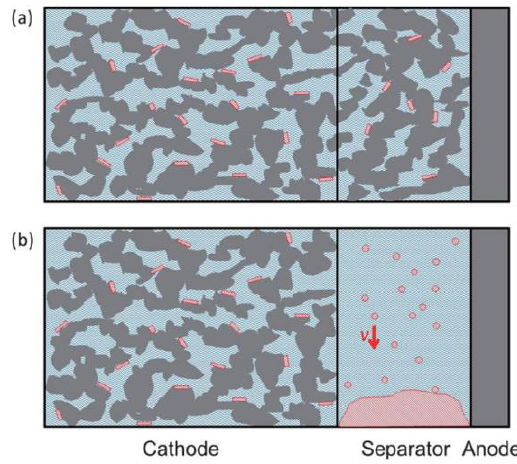
Figure 22. Schematic of precipitation kinetics: ( a ) nucleation on surfaces in a porous separator and a cathode and ( b ) nucleation on dust particles inside a separating bulk electrolyte with sedimentation due to gravity. Reprinted from Horstmann et al. [29], with permission from The Royal Society of Chemistry.